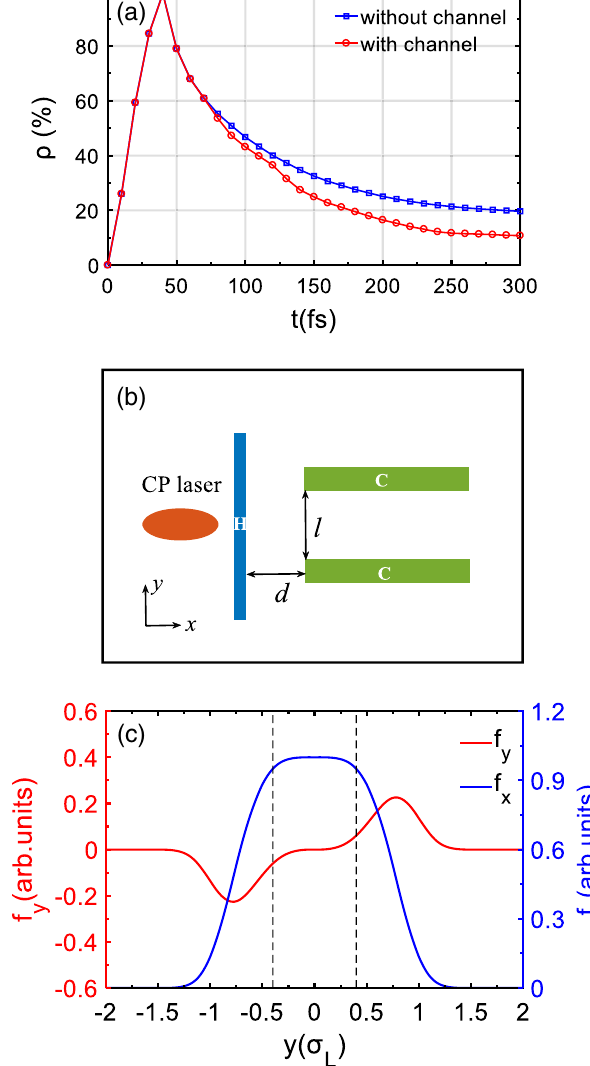
FIG. 3. (a) Temporal evolution of ρ ¼ E r =E residual energy of the laser pulse and E the laser pulse. (b) Schematic diagram of proton acceleration by the employment of an additional plasma channel. (c) Transverse and longitudinal ponderomotive force profile of a fourth-order super-Gaussian laser along the y